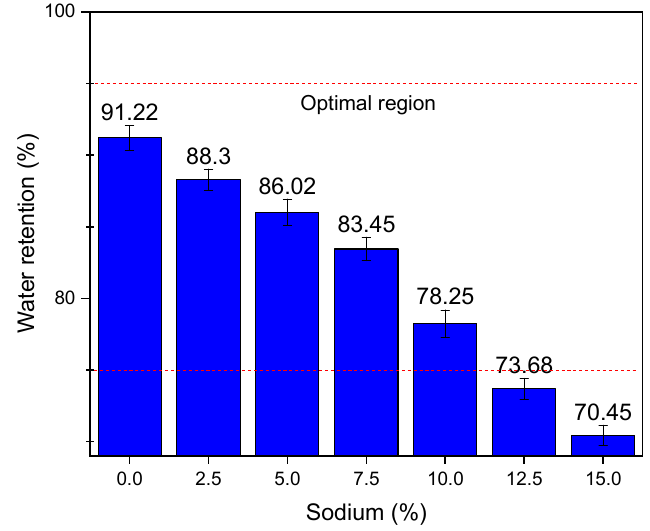
Figure 7. Results of water retention as a function of the sodium content.